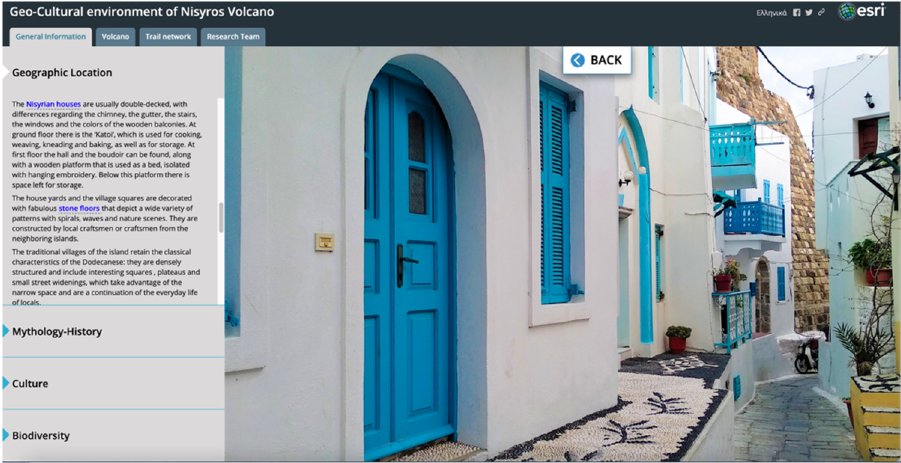
Figure 7. Screenshot showing the “stone floors”, a typical characteristic of Nisyros’s architecture. Users can select the highlighted words in the accompanying narration to change the main stage content.